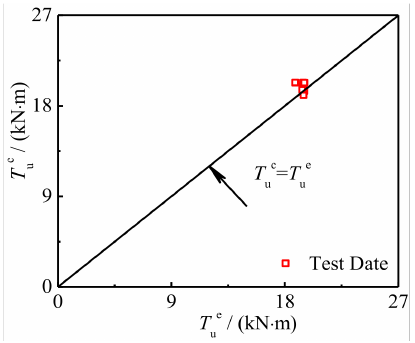
Figure 27. Comparison between T uc and T ue of